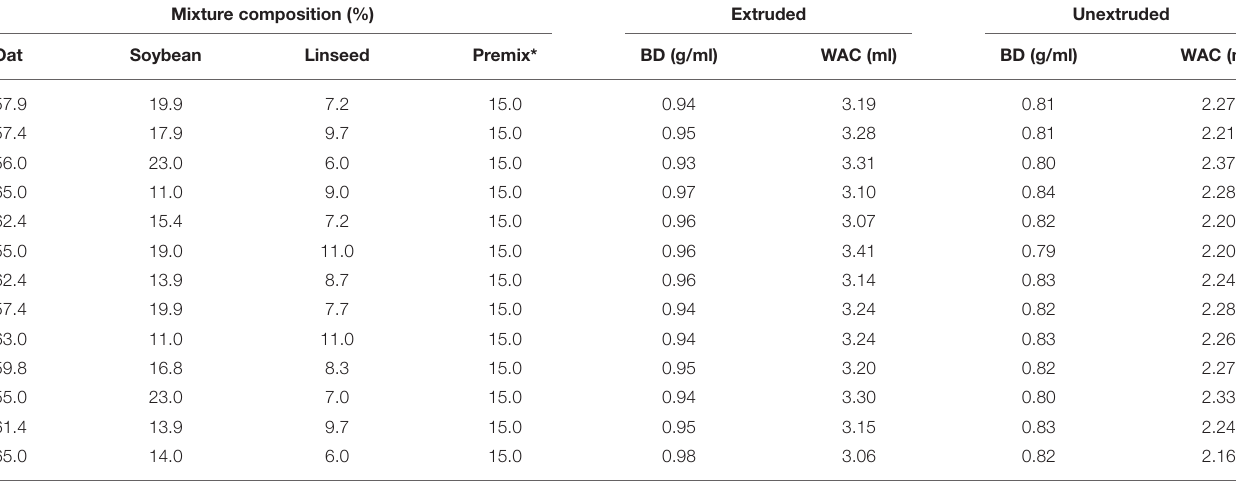
TABLE 6 | Functional properties of unextruded and extruded composite flour. Mixture composition